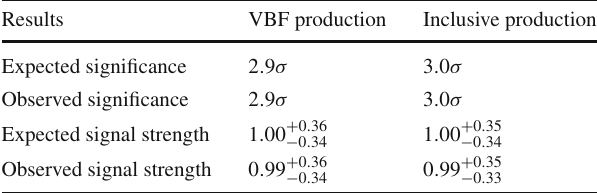
Table 6 Expected and observed results for the Higgs boson production rate, for both inclusive production and VBF production only, relative